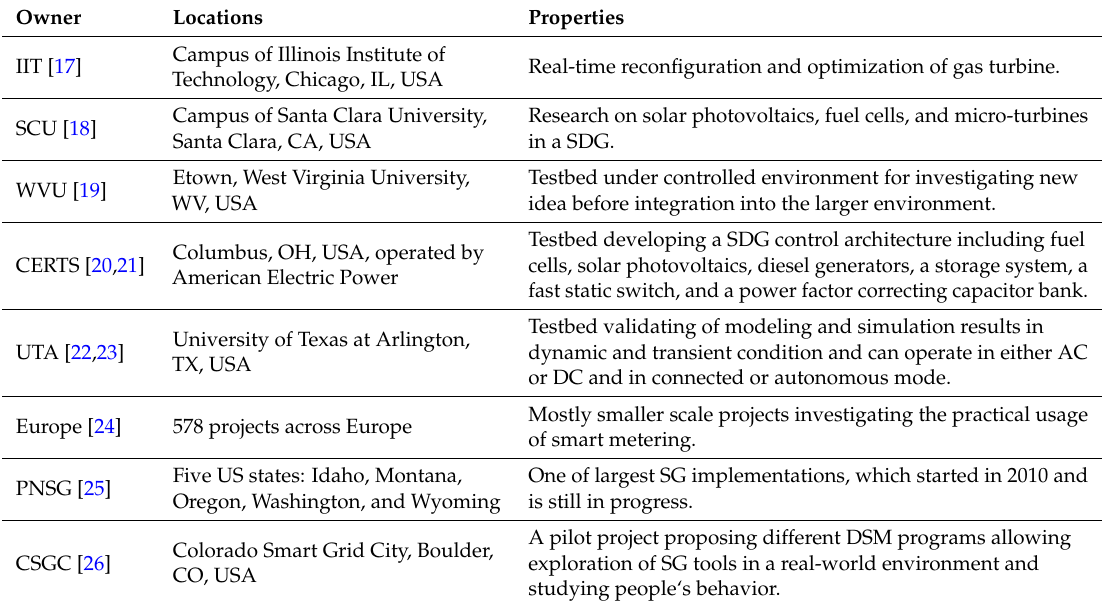
Table 1. Major SG implementations in the